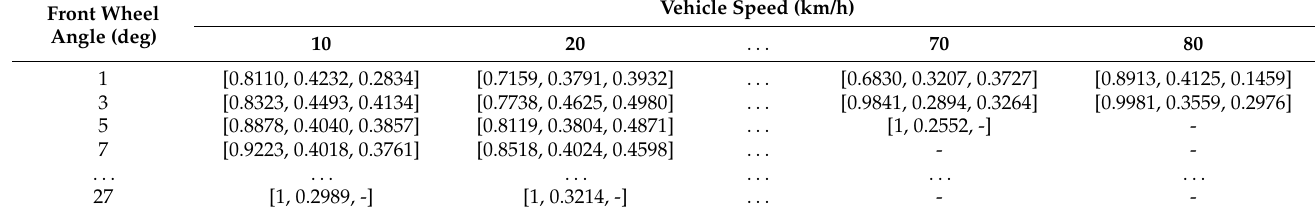
Table 3. Torque distribution coefficient.